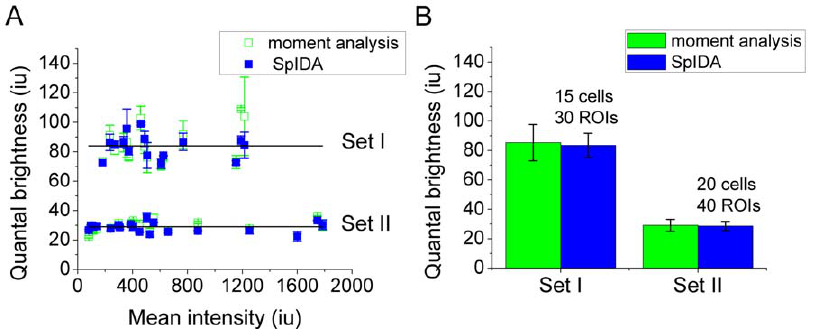
Figure 2. The measurements of quantal brightness of monomeric EGFP for two distinct sets of imaging conditions (referred as ‘‘Set I’’ and ‘‘Set II’’ throughout the text). Set I corresponds to pixel size of 0.046 m m, with the scan speed set to ‘‘fast’’ (18.1 m m/ m s), and Set II - pixel size of 0.0921 m m, with the scan speed set to ‘‘slow’’ (10.1 m m/ m s). The values of e were recovered with both fluorescence moment image analysis and SpIDA for comparison purposes. The error bars were calculated as the standard error of images of multiple cells. A) measured quantal brightness for various values of the mean intensity; B) average values (with error bars) for sets I & II.